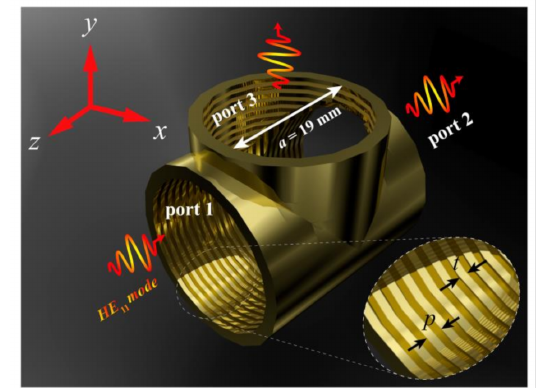
Figure 6. 3D structure of the three-port directional coupler.